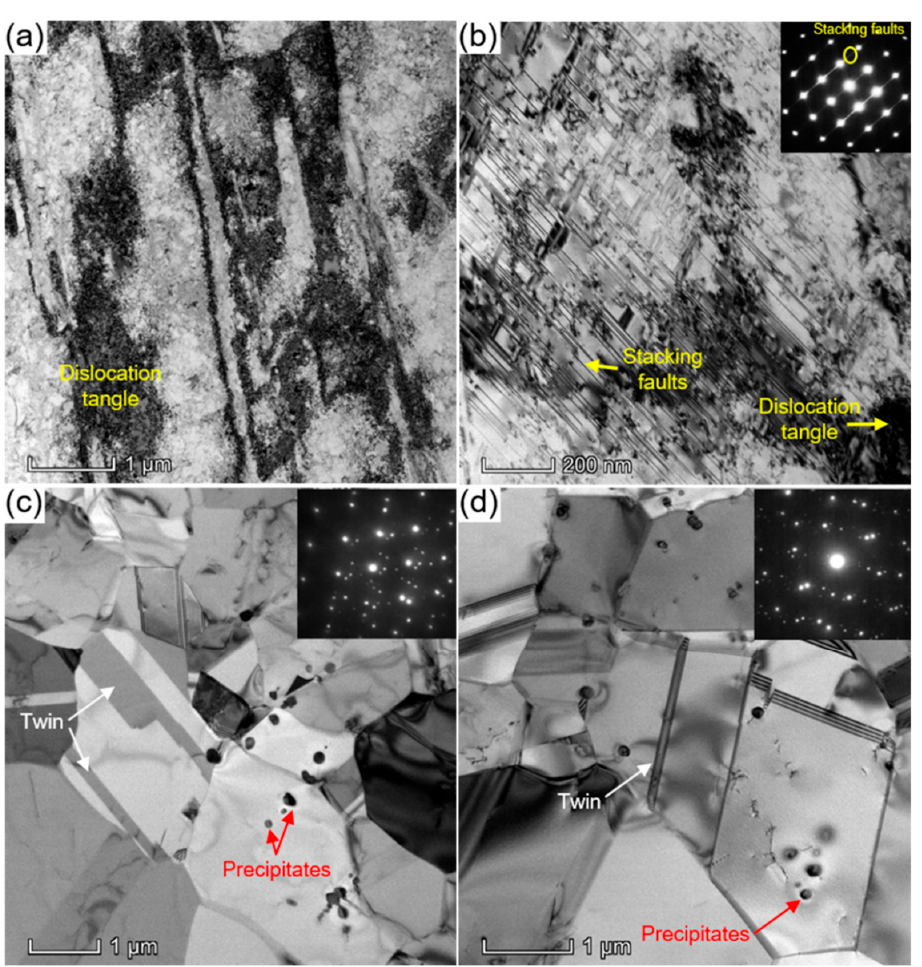
Figure 2. TEM bright-field images showing the microstructure of the ( a ) hot-rolled (HR), ( b ) warm- rolled (WR), ( c ) cold-rolled and heat-treated at 973 K for 30 min (HT1), and ( d ) cold-rolled and heat-treated at 1023 K for 30 min (HT2) of the Co 35 Cr 25 Mn 15 Ni 15 Fe 10 HEA.